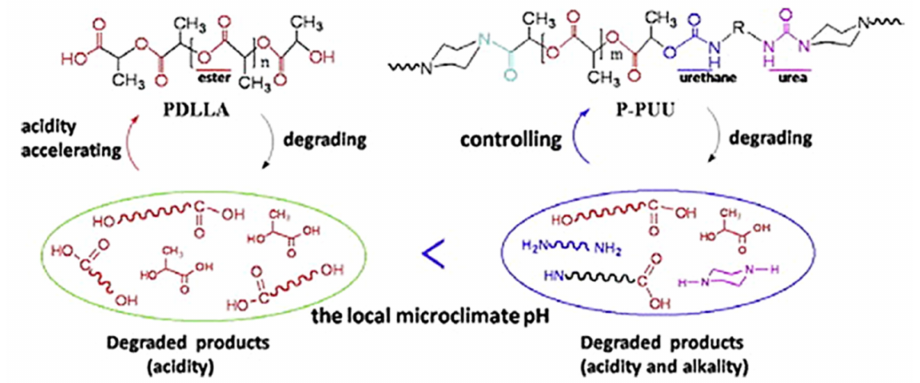
Figure 13. The degradation of PLA and P-PUUs. Reprinted from [137] with permission from Elsevier. Another oligodiol used for PU production is PEG. PEG is nontoxic, and soluble